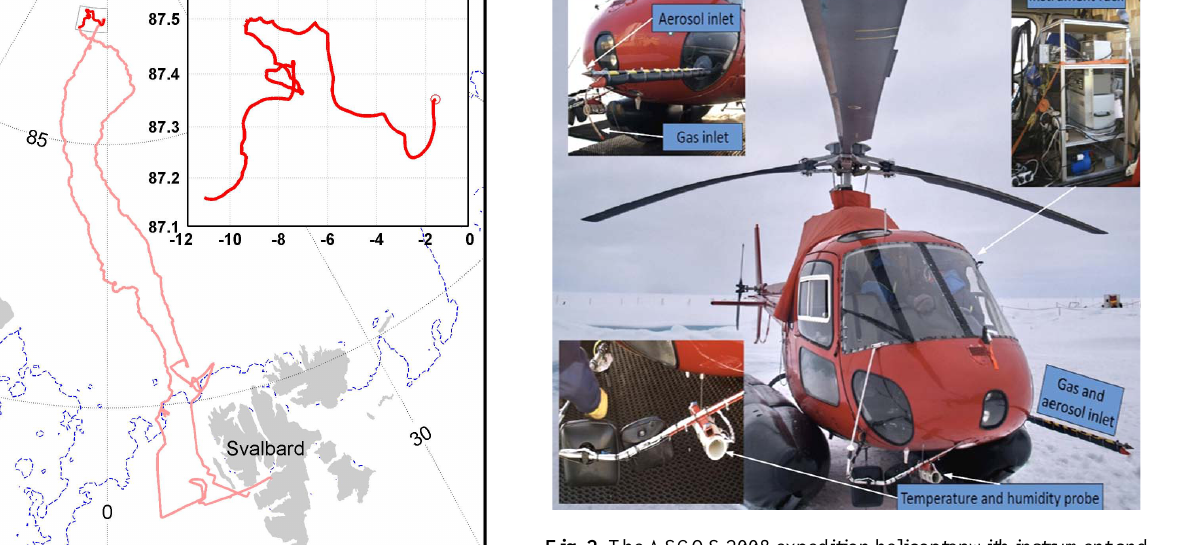
Fig. 2. The ASCOS 2008 expedition helicopter with instrument and air inlet